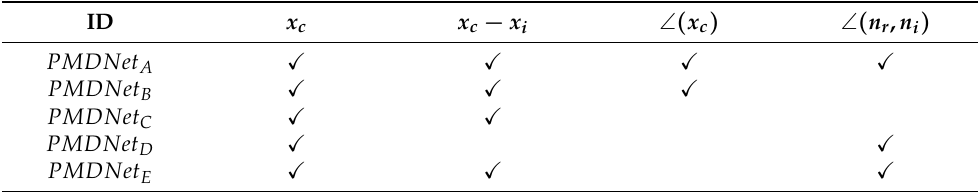
Table 4. Ablation setup. PMDNet A , PMDNet B , PMDNet C , PMDNet D , PMDNet E select different components of the PMD feature.